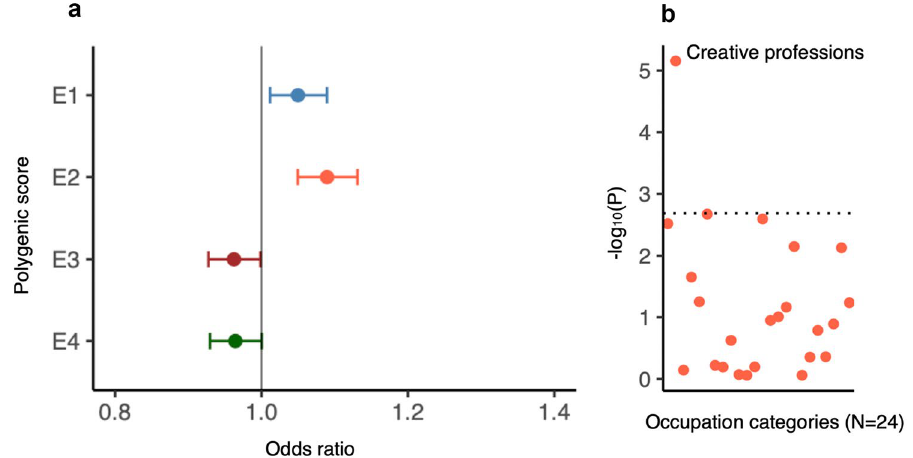
Figure 6. Genetic associations of E-factors with creativity. ( a ) Associations of polygenic scores for E-factors with creative professions (‘arts, design, entertainment, sports and media’ vs rest) in MVP tested using logistic regression; odds ratio and 95% confidence intervals are shown; ( b ) Associations of polygenic scores for E-factors with all 24 occupation categories in the MVP tested using logistic regression; Negative log10 P values are shown; the dotted line statistical significance threshold after multiple testing correction (P =